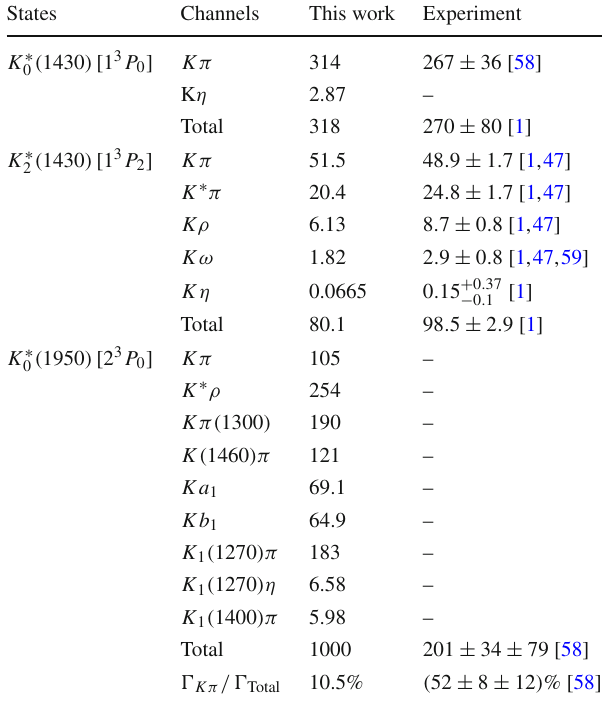
Table 6 The decay widths of three P -wave states. The unit of the width is MeV States